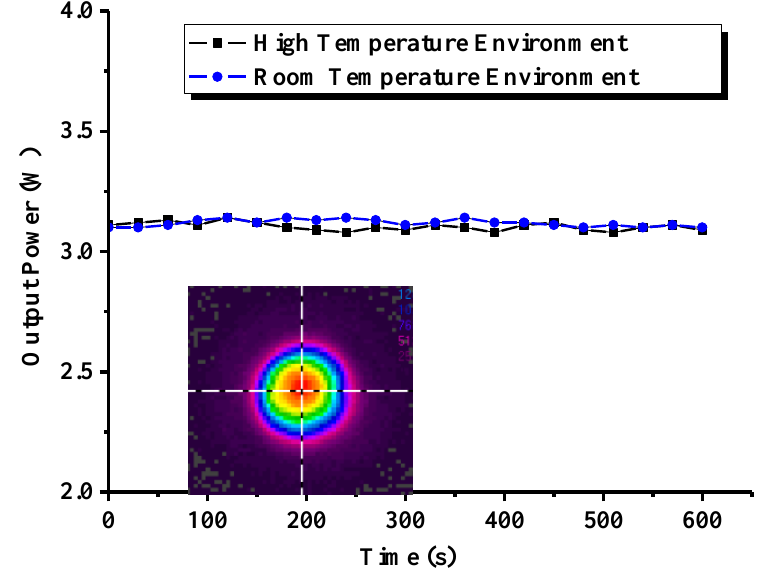
Figure 13. Output power variation and near-field pattern of the OPO laser.